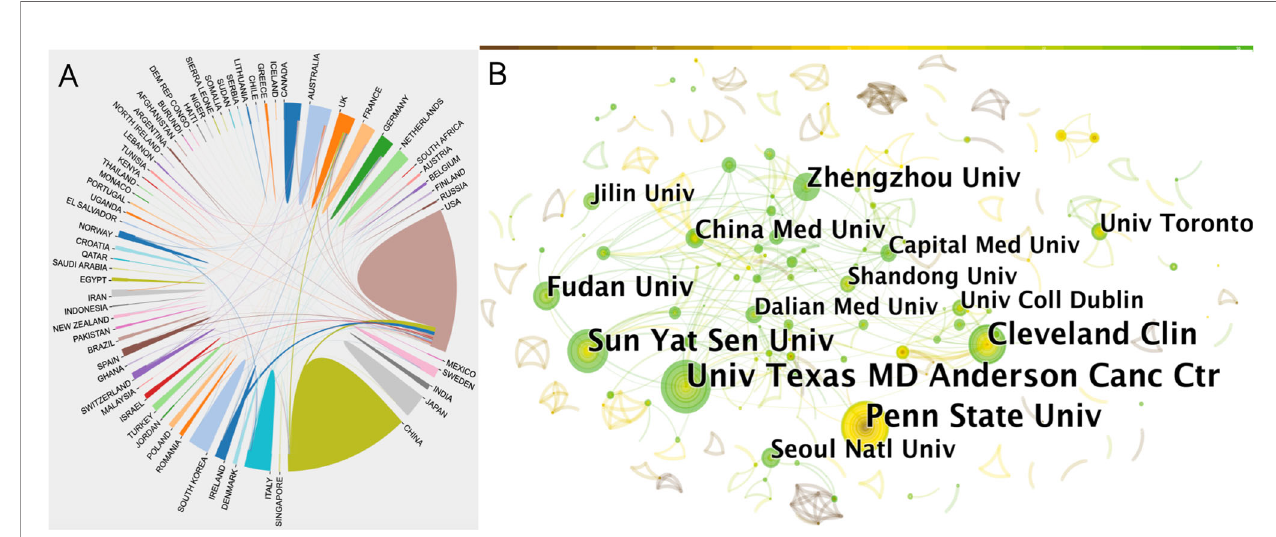
FIGURE 2 | (A) Collaboration efforts between 65 countries/regions on the topic of anesthesia and tumor prognosis from 2001 to 2020. Data output from the Online Analysis Platform of Literature Metrology (http://biblimetric.com). (B) Citespace network map of institutions involved in anesthesia and tumor prognosis research. Each circle represents an institution. Size of circle is positively correlated with the number of articles published by institutions, and links between two circles represents a collaboration between two institutions on the same article. Line thickness is positively correlated with frequency of collaborations. Top 10 institutions with the most publications are shown. (US Texas MD Anderson Cancer Center, Penn State Univ, Sun-Yat Sen Univ, Cleveland Clin, Fudan Univ, Zhengzhou Univ, China Med Univ, Seoul Natl Univ, Univ Toronto were top 9 and Dalian Medical University, Jilin University, University college Dublin, Shandong University and Capital Medical University tied for tenth). Timespan: 2001-2020; Slice length =